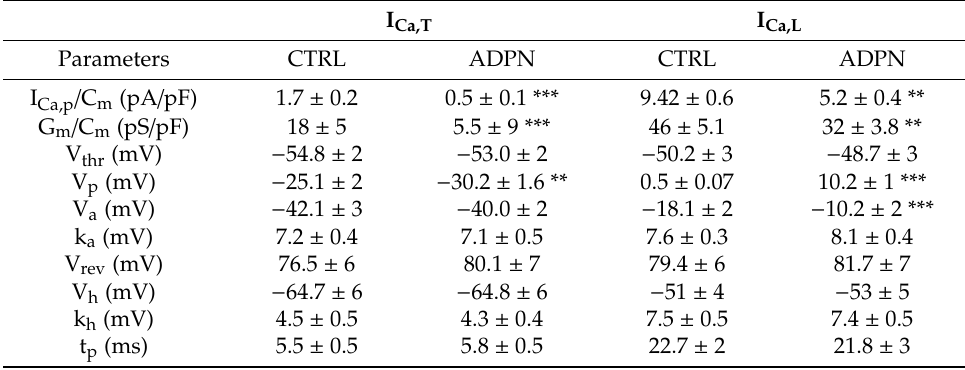
Table 2. Boltzmann parameters of I Ca,T and I Ca,L activation and inactivation obtained in gastric SMCs in control condition (CTRL) and after adiponectin (ADPN)